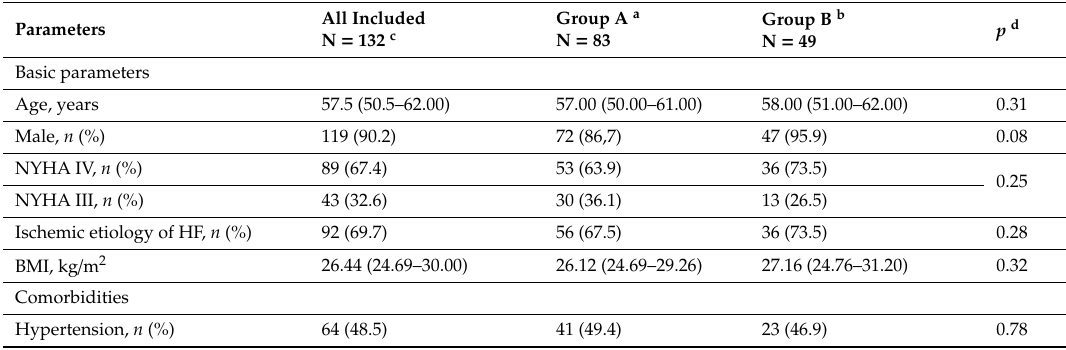
Table 1. Baseline characteristics of the study